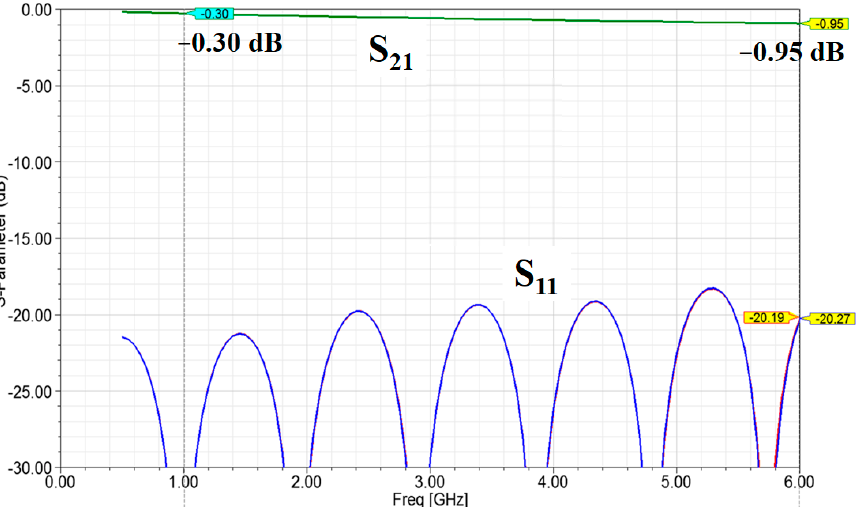
Figure 5. Simulation setup for full-wave EM simulation software. S 11 is the return loss of port 1. S 21 is the insertion loss from port 1 to 2.